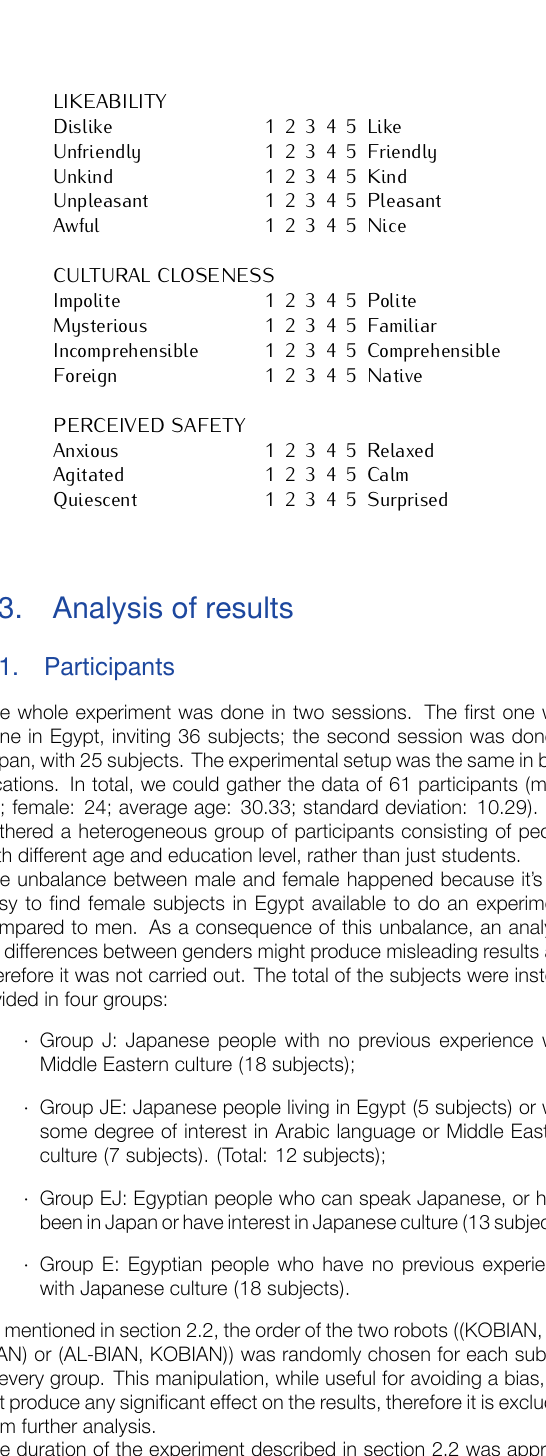
Figure 5. This graph reports the reasons why subjects expressed a preference for one